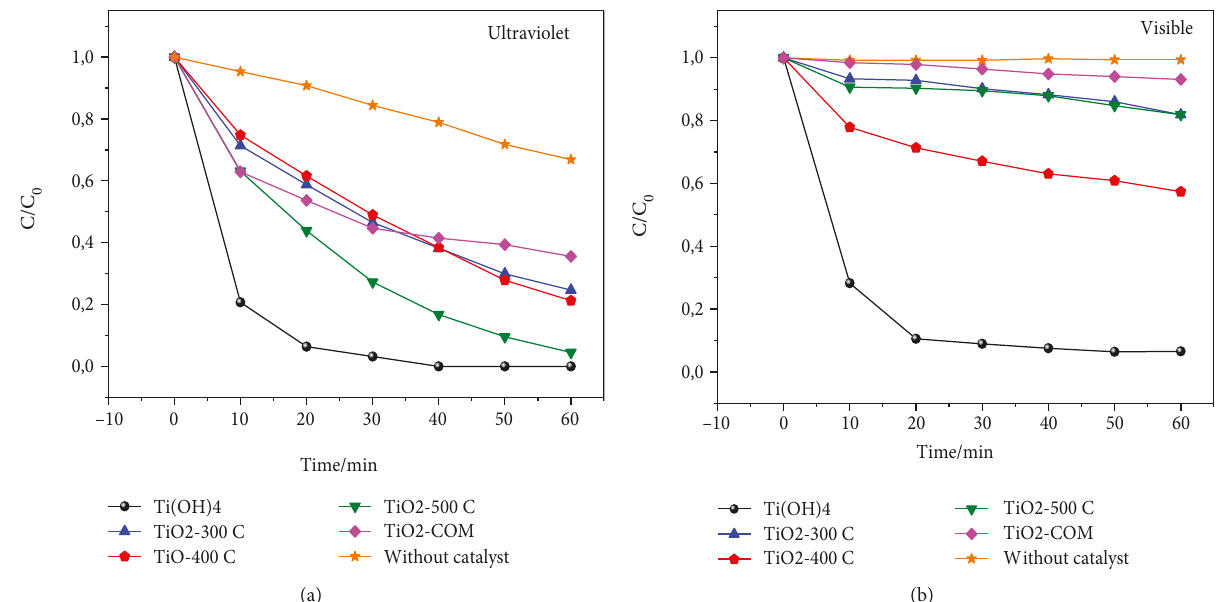
Figure 8: Degradation kinetics of AML (a) under UV and (b) visible light radiation in the solutions containing Ti(OH) TiO -300 ° C, TiO -400 ° C, and TiO 2 2